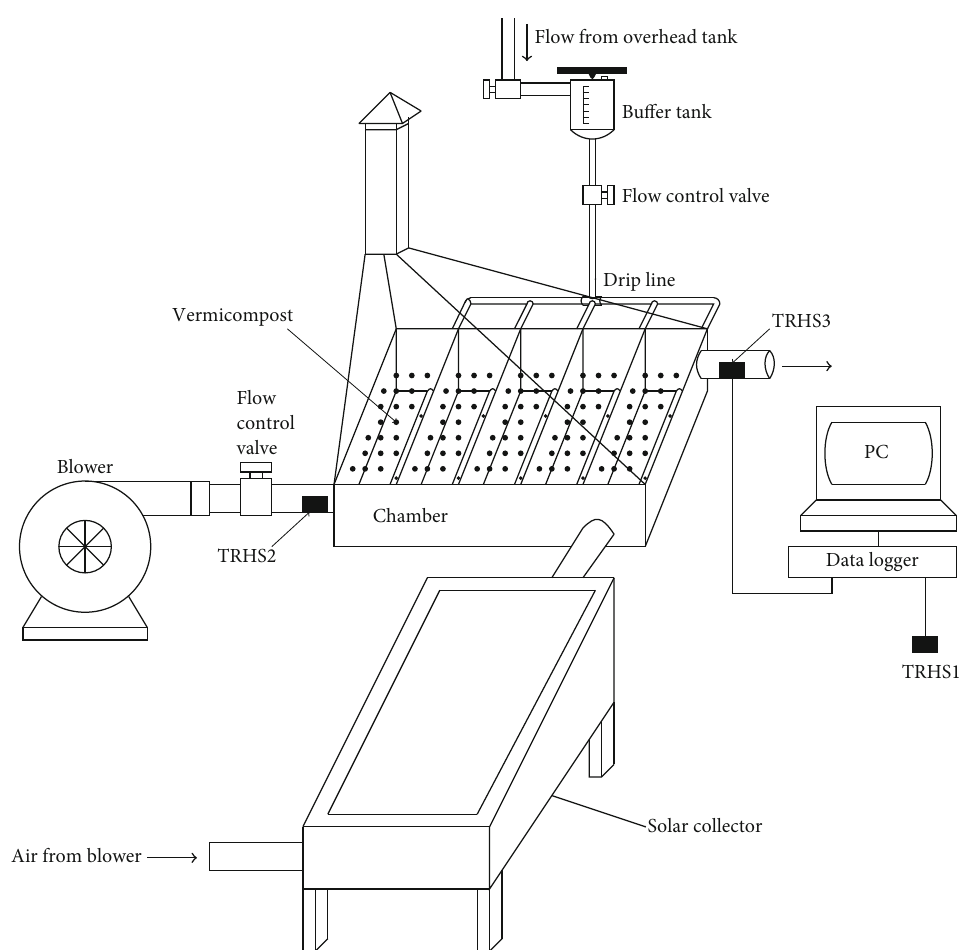
Figure 3: Schematic of the experimental setup. TRHS: temperature and relative humidity sensor.